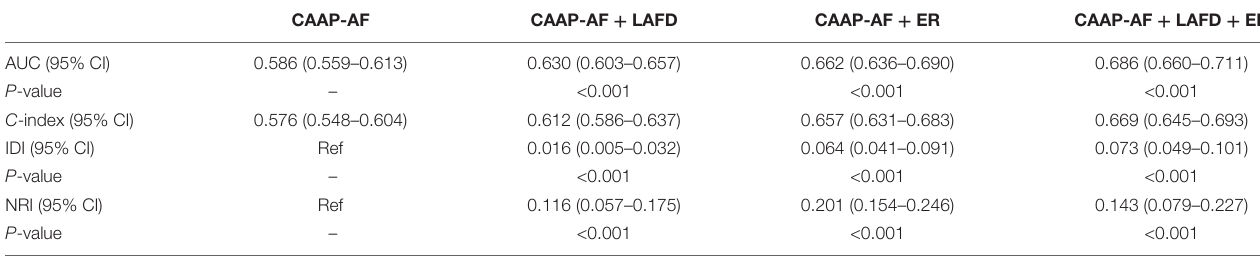
TABLE 3 | Comparison of different risk prediction